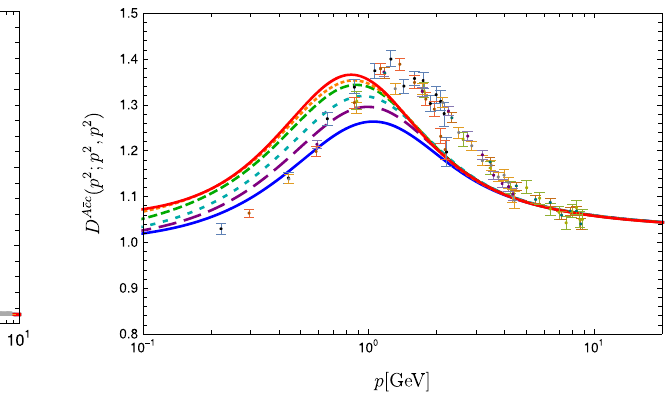
gluon vertex dressing function at the symmetric point in comparison to SU ( 2 ) lattice data [53]. Different lines correspond to different decou- pling/scaling solutions as explained in the